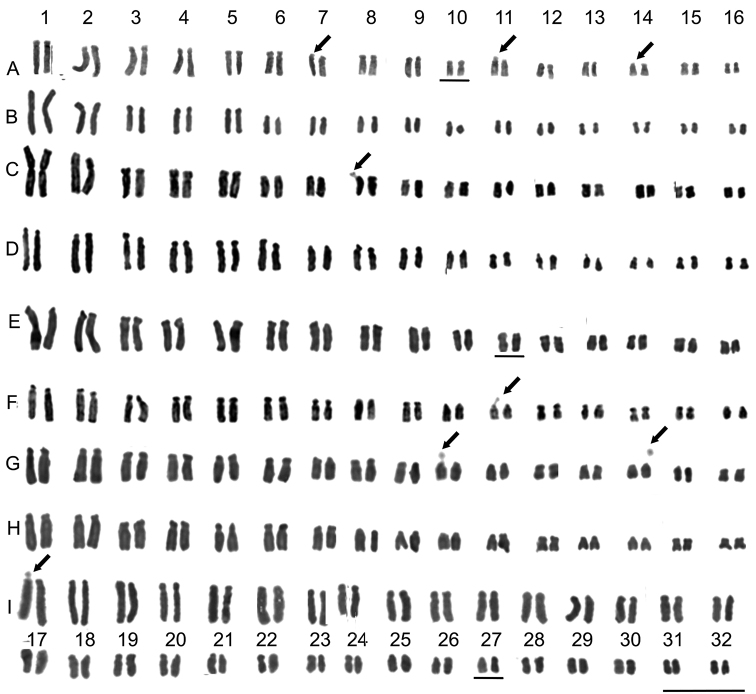
Karyotypes of Smilax species: Feulgen-stained metaphase chromosomes. AS.
rufescensBS.
fluminensis (Uruana access) CS.
fluminensis (Itirapina access) DS.
polyantha (Botucatu access) ES.
polyantha (Mogi Guaçu access) FS.
brasiliensisGS.
campestrisHS.
cissoidesIS.
goyazana. Arrows indicate secondary constrictions and satellites. Note the heteromorphic pair 10 in S.
rufescens, pair 11 in S.
polyantha (Mogi Guaçu) and pair 27 in S.
goyazana. Scale bar: 10 µm.